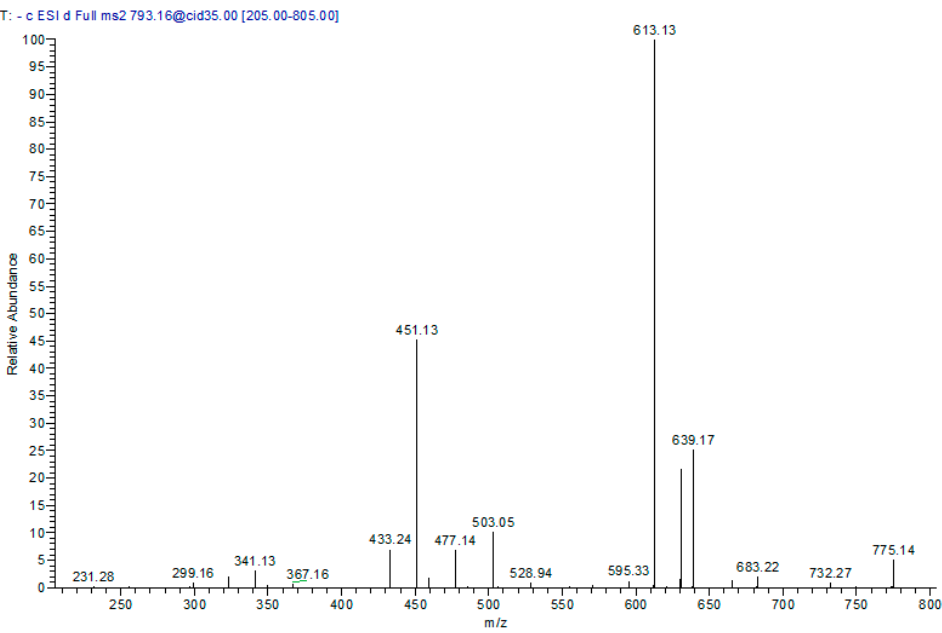
Figure 4. MS/MS spectra of cinchonain-I syringyl-hexoside at [M − H] − m / z 793.